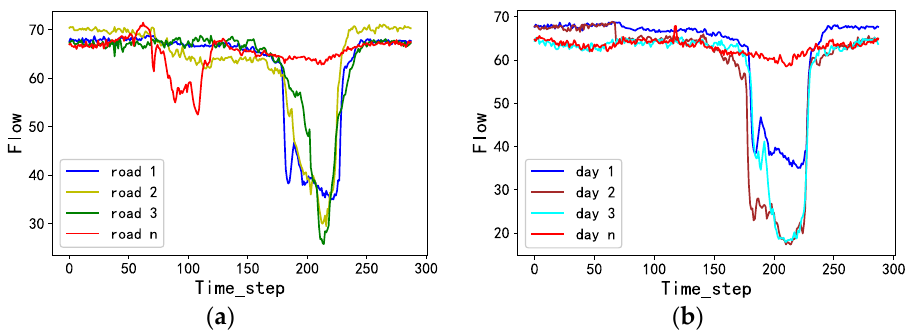
Figure 1. Traffic flow on different roads and times in a day. ( a ) At a specific time, roads 1, 2, 3 represent the traffic flow of three adjacent sensors and road 𝑛 represents the traffic flow of a non ‐ adjacent sensor; ( b ) at a specific sensor, days 1, 2, 3 represent the traffic flow of three adjacent days and day 𝑛 represents the traffic flow of a non ‐ adjacent day.